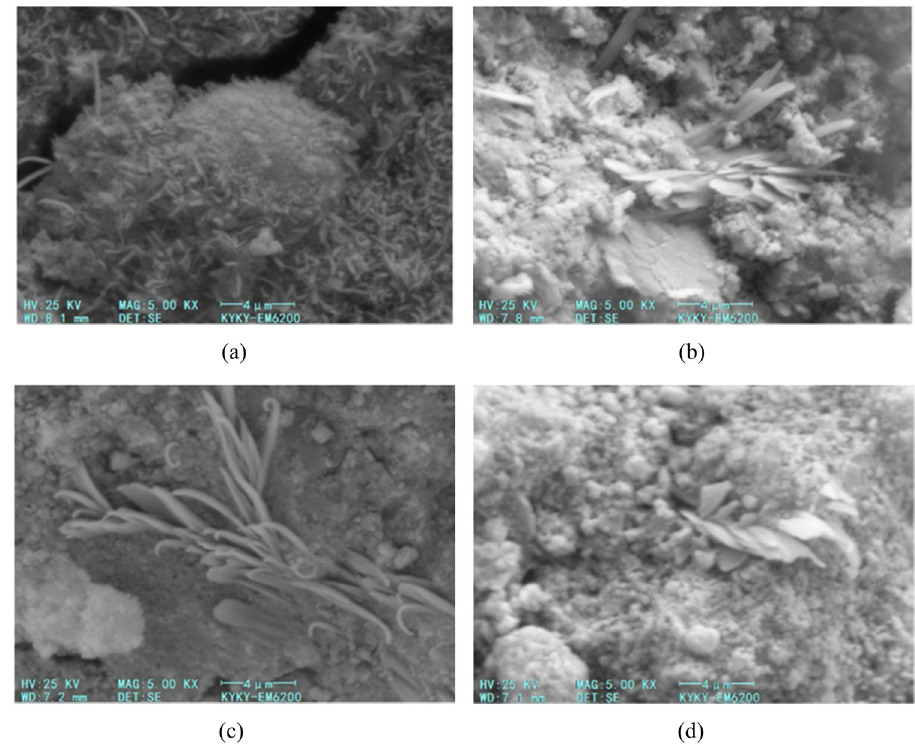
Figure 13: Micrographical diagram of geopolymer with di ff erent content nano - SiO 2 at 200°C and 400°C [ 92 ] . ( a ) 200°C:Si - 0.5, ( b ) 200°C:Si - 2.5, ( c ) 400°C:Si - 0.5, and ( d ) 400°C:Si -